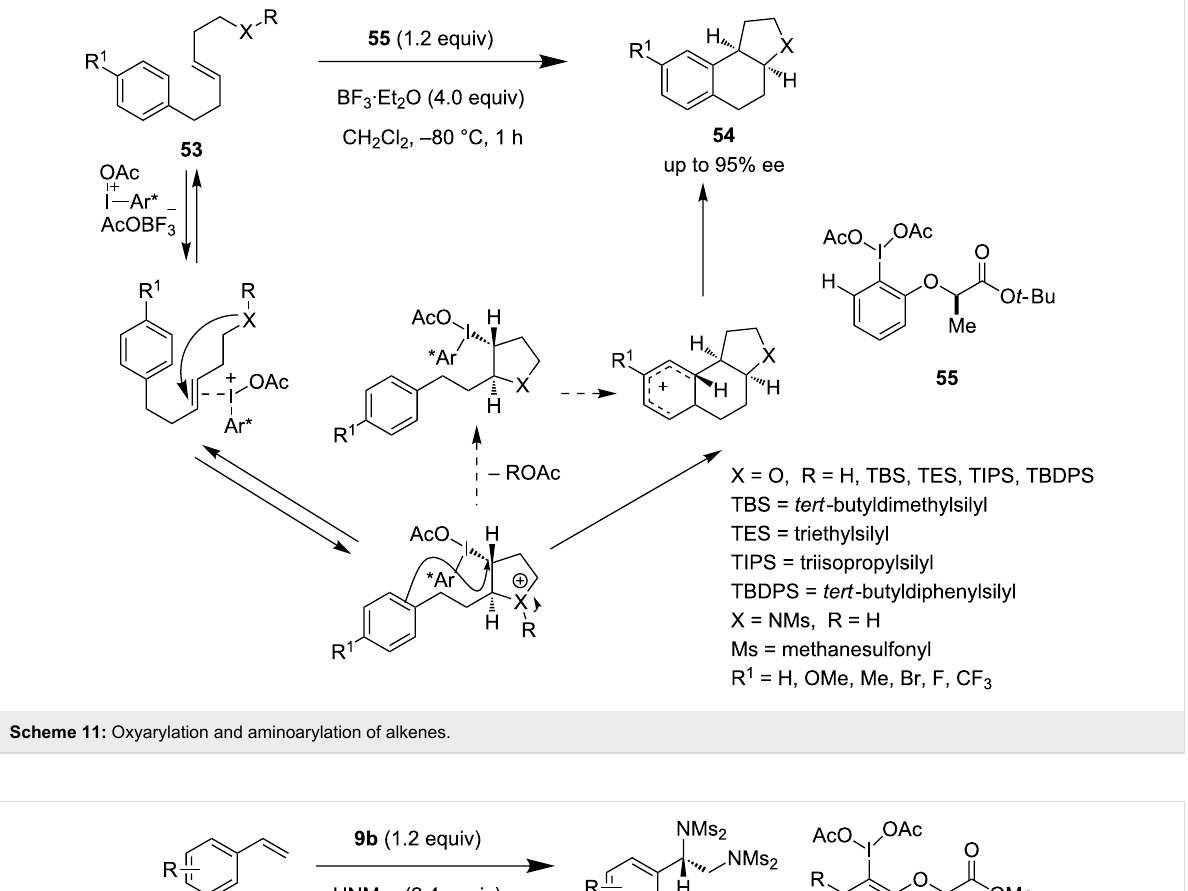
Scheme 11: Oxyarylation and aminoarylation of alkenes.